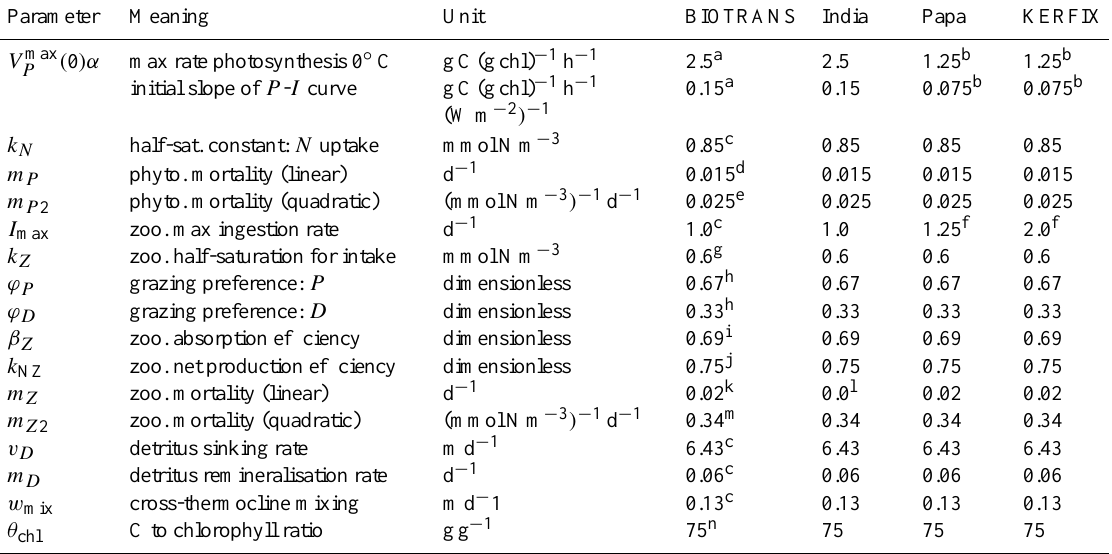
Table 3. Model parameters. Fitted model solutions for stations BIOTRANS, India, Papa and KERFIX. The initial (unfitted) parameter guesses for BIOTRANS were as for the fitted solution, except that parameters m P and kZ were tuned from initial settings of 0.02d − 1 and 0.86mmolNm − 3 respectively (see text and footnotes).